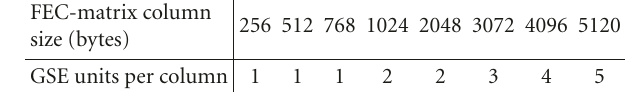
Table 2: Parameters of the GSE-FEC algorithm. FEC-matrix